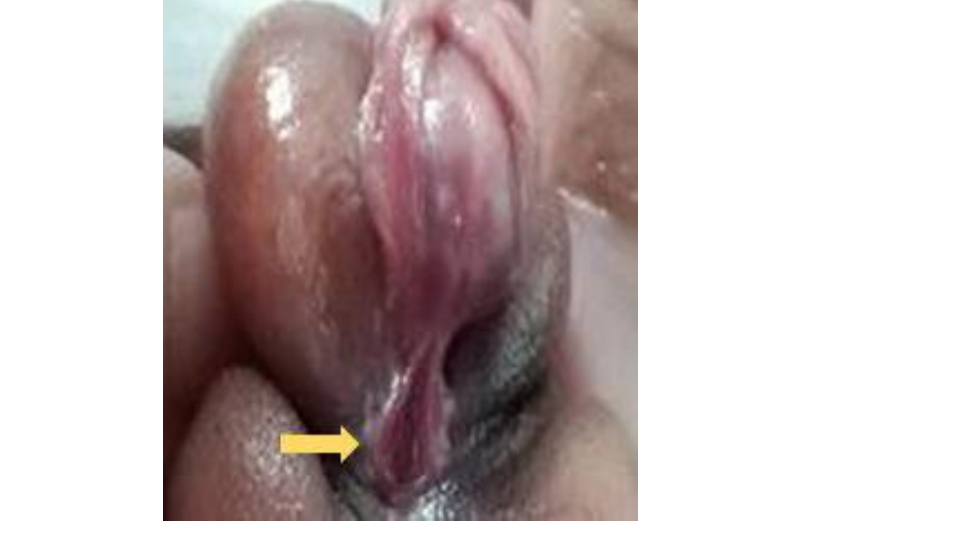
Figure 12. Third degree (severe) hypospadias with meatus opening over penoscrotal area (arrow).